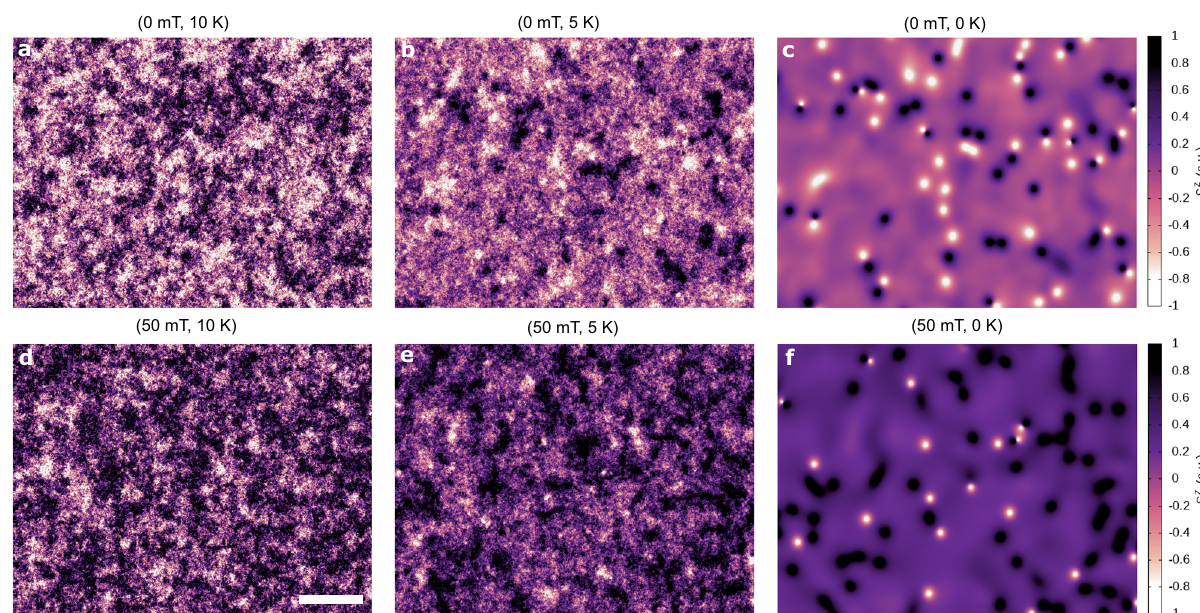
Fig. 1 Nucleation of merons and antimerons during the cooling process. a – c Dynamical spin con fi gurations obtained at different temperatures ( T ) showing the evolution of the domain structure and the formation of merons and antimerons during fi eld cooling in an external fi eld of 0.0 mT. The S z component is used to follow the evolution of the different spin textures across the crystal surface (color map). Strong spin fl uctuations are observed at temperatures below the critical temperature ( T c = 19.07 K, see Supplementary Fig S1), which incidentally vanished as the system cools down. Localized small areas within 0 K ≤ T ≤ 5 K correspond to spins pointed perpendicular to the easy-plane of CrCl 3 in different spin polarizations (e.g., + 1 or − 1). At 0 K, most of the magnitudes of S z are zero throughout the crystal except at well de fi ned small spots with either S z = + 1 or S z = − 1 in their cores. The formation of merons and antimerons occur simultaneously during the time evolution without a clear preference over the nucleation site. That is, boundaries, defects or edges are not considered. d – f Similar to a – c but at an external fi eld of 50 mT. The applied fi eld polarizes the spin con fi gurations resulting in less fl uctuations along of S z even though with alike domain dynamics. At T ≤ 5 K, the merons and antimerons are still formed but with a more preferential spin polarization, e.g., darker spots. If larger magnetic fi elds beyond 50 mT are applied (e.g., 100 mT), a full polarization of the topological spin textures is observed with a totality of just one kind of spin polarization. For fi elds above 150 mT, there is no additional nucleation of merons and antimerons throughout the crystal as the spin textures outside the vortex core follows the fi eld direction. See Supplementary Figs. S2, S3 and Supplementary Movies S1 – S3 for details. Scale bar is 50